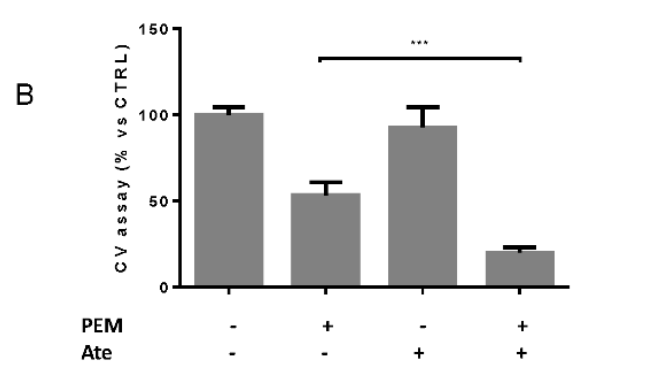
Figure 7. Atezolizumab increased T cell-mediated cytotoxicity in A549 cells treated with pemetrexed. A549 tumor cells and PBMCs activated with anti-CD3 (1 µ g / mL) and anti-CD28 (2 µ g / mL) were co-cultured in transwells for 3 days with or without 100 nM pemetrexed. Then PBMC were transferred to contacting co-culture by transferring them from the insert to the corresponding well with a ratio of approximately 5:1 (e ff ector: target cells) for 24 h with or without 200 µ g / mL atezolizumab. ( A ) Images of A549 cells co-cultured with PBMCs in the absence or presence of 100 nM pemetrexed with or without 200 µ g / mL atezolizumab. Scale bar: 100 µ m. ( B ) Crystal violet assay *** p < 0.01. Data in ( B ) are the average of three independent